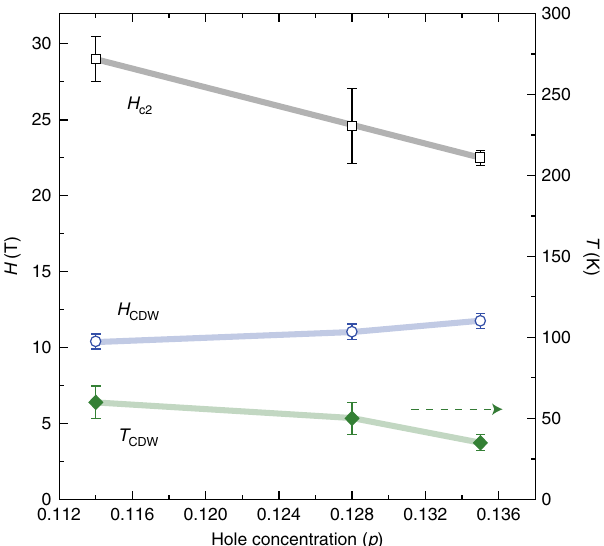
Fig. 5 The relationship between superconductivity and the CDW in underdoped Bi2201. Doped hole concentration dependence of the upper critical fi eld H c2 , H CDW (left axis) and T CDW (right axis). Error bars represent the uncertainty in the fi t using WHH formula to obtain H c2 (Supplementary Fig. 5) and in de fi ning the onset fi eld H CDW and temperature T CDW